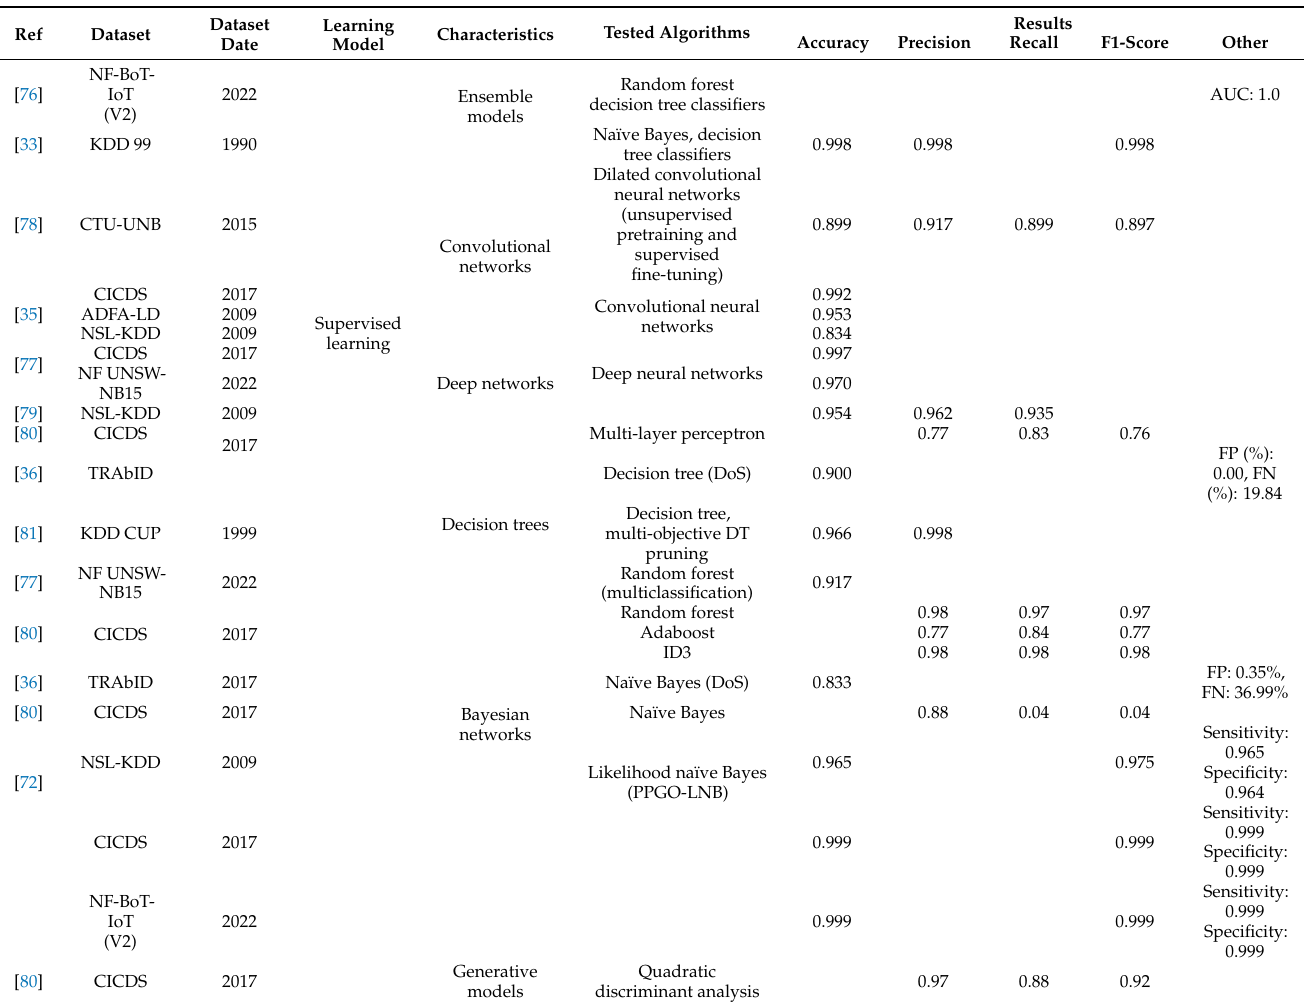
Table 5. Datasets and ML to develop